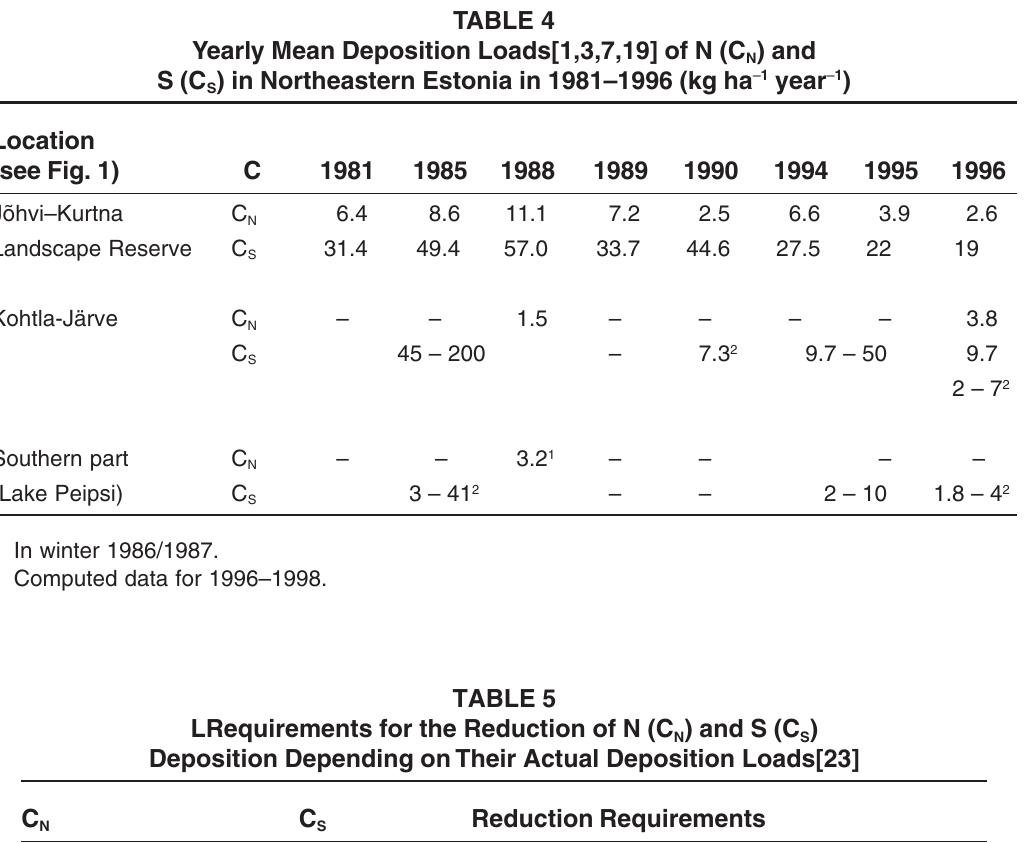
LRequirements for the Reduction of N (C